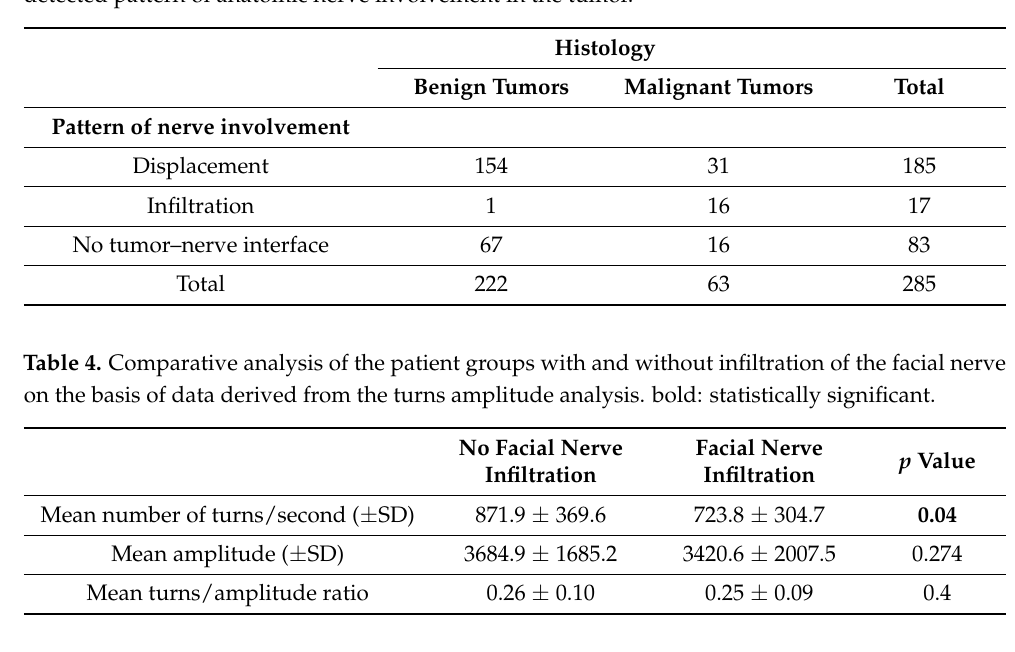
Table 3. Correlation of the histology of the tumors of the study sample with the intraoperatively detected pattern of anatomic nerve involvement in the tumor.